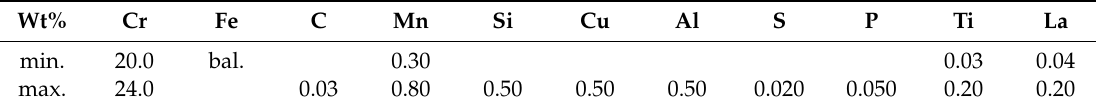
Table 2. Crofer22APU Chemical composition (wt%) according to the ThyssenKrupp datasheet [39]. Wt%